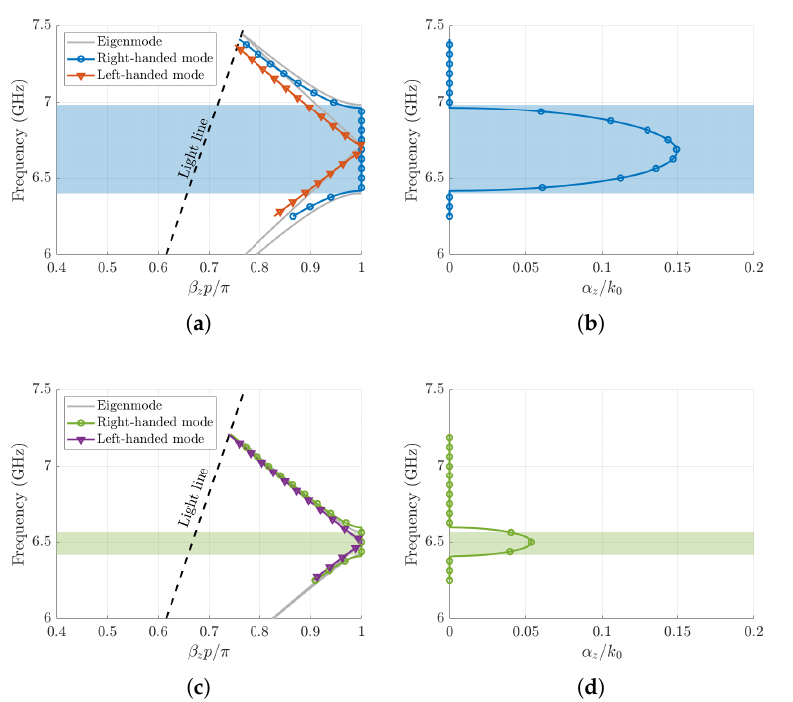
Figure 8. Dispersion diagram computation using Bloch multimode for a twist-symmetric dielectric rod with parameters: p = 15.4mm, w = p /4, r 1 = 7mm and (cid:101) 1 = 10. ( a ) Phase constant and ( b ) attenuation constant of the right-handed polarized mode with r 2 = 4.2mm and (cid:101) 2 = 3. ( c ) Phase constant and ( d ) attenuation constant of the right-handed polarized mode with r 2 = 6mm and (cid:101) 2 = 5. The shaded region indicates the bandgap calculated using the eigenmode solver.